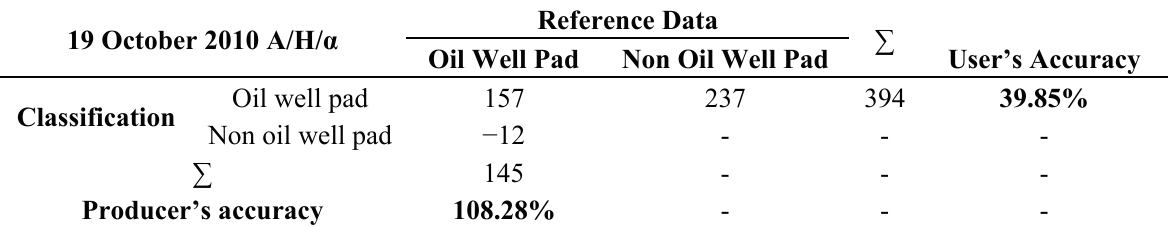
Table 6. Number-based accuracy assessment for TerraSAR-X acquisition 19 October 2010—A/H/ α